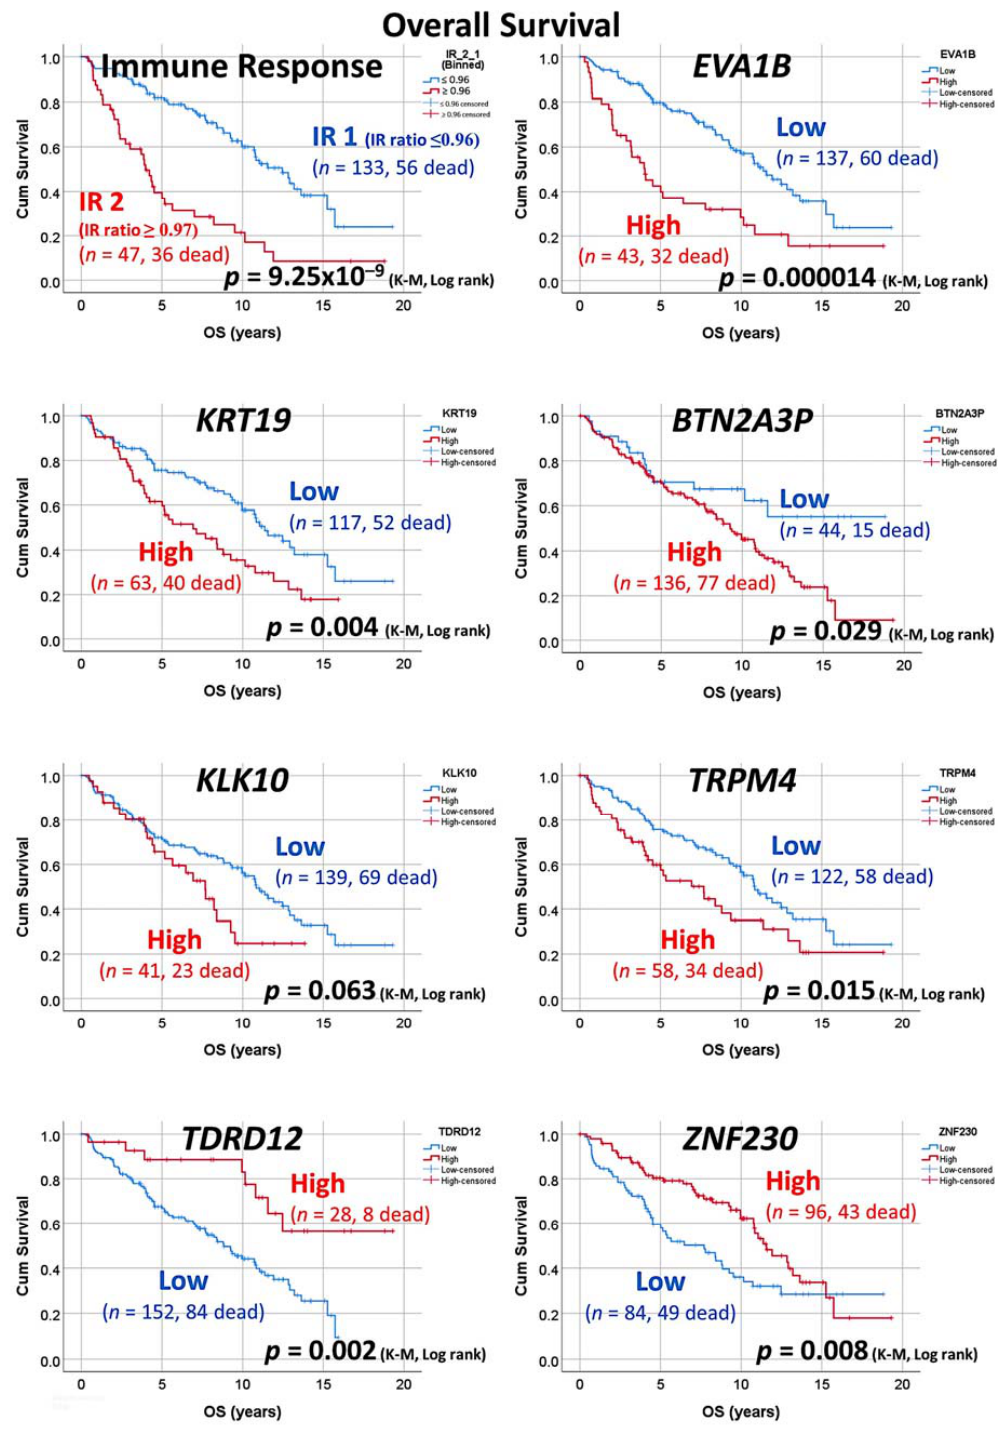
Figure 8. Overall survival with Kaplan–Meier analysis. Based on the GSEA results, a group of genes was selected. After finding the more adequate cut-o ff , a group of patients with high and low expression was found with correlation to the overall survival. Bad OS genes were EVA1B , KRT19 , BTN2A3P , KLL10 , and TRPM4 . Good OS genes were TDRD12 and ZNF230